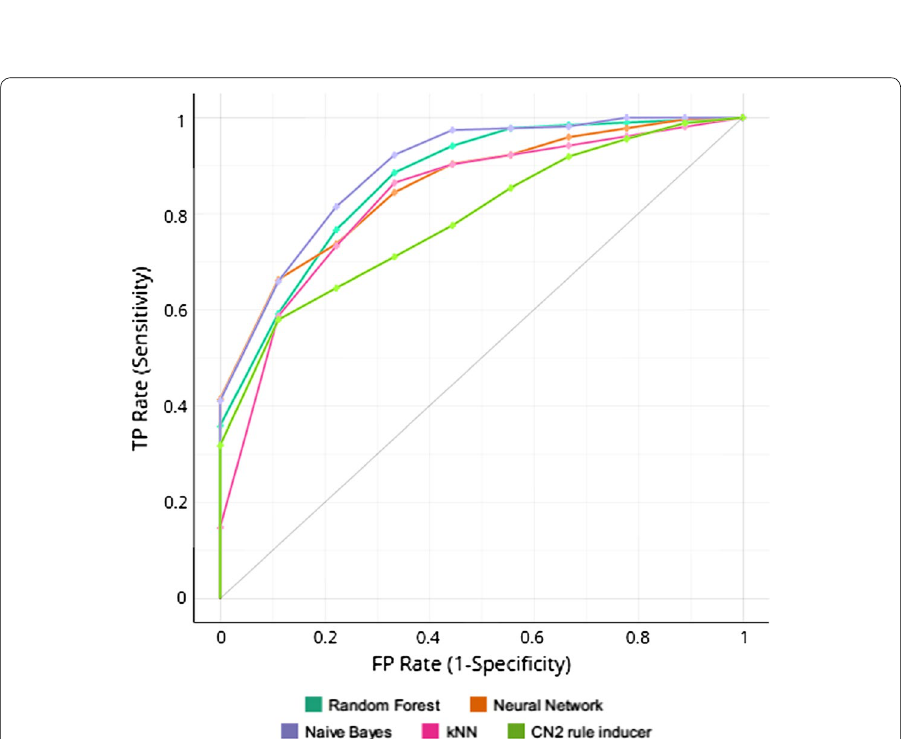
Fig. 17 ROC for the LDT IP upload